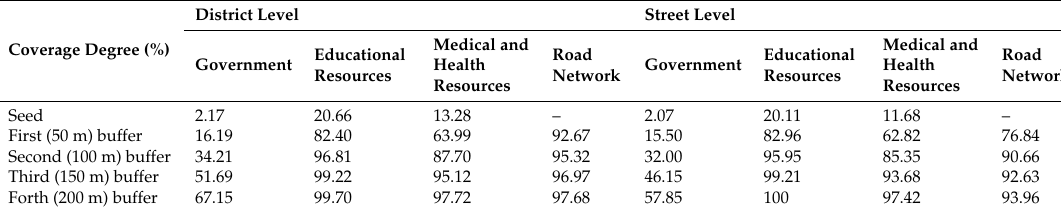
Table 4. Population Coverage by Multiple Buffers.